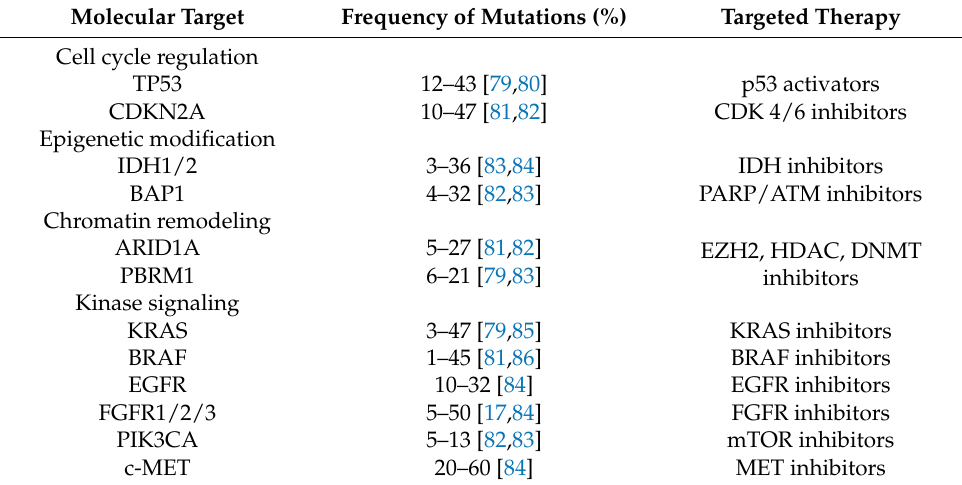
Table 3. Overview of actionable genomic mutations identified in cholangiocarcinoma and potential therapeutic